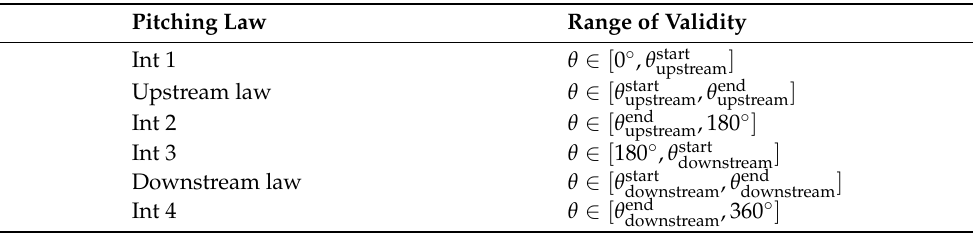
Table A4. Range of validity (for θ ) of each sub-part of the pitching law. Pitching Law Range of